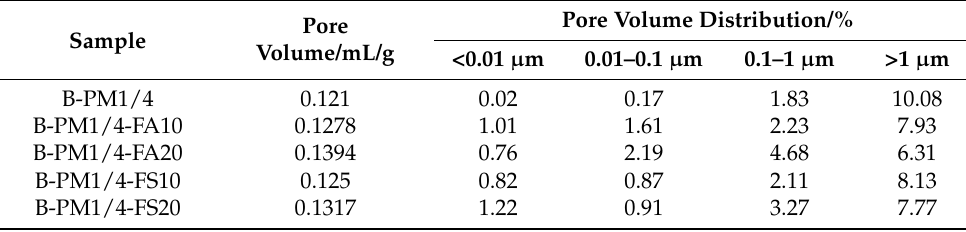
Table 5. Effect of mineral admixtures on pore structure of MPC.